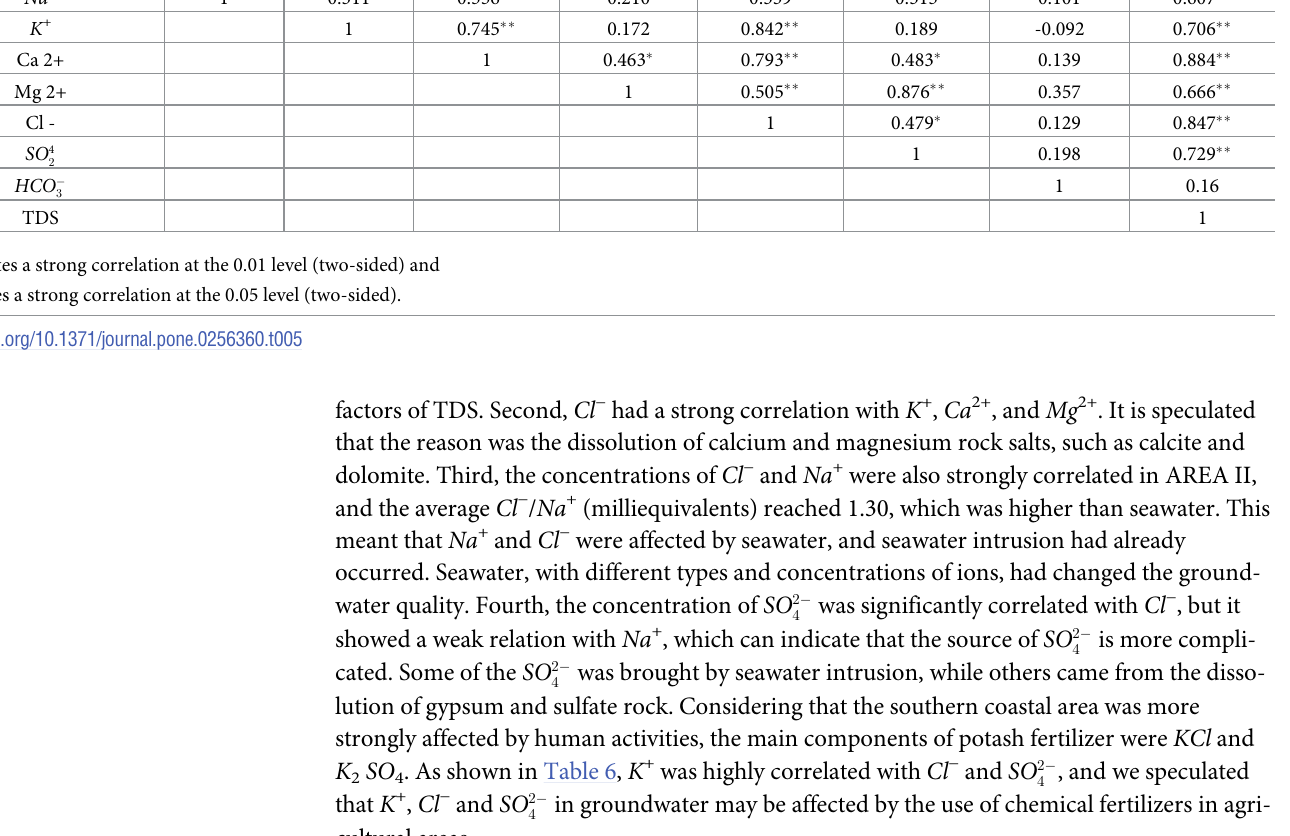
Table 5. Pearson correlation analysis of the main indicators in AREA I.